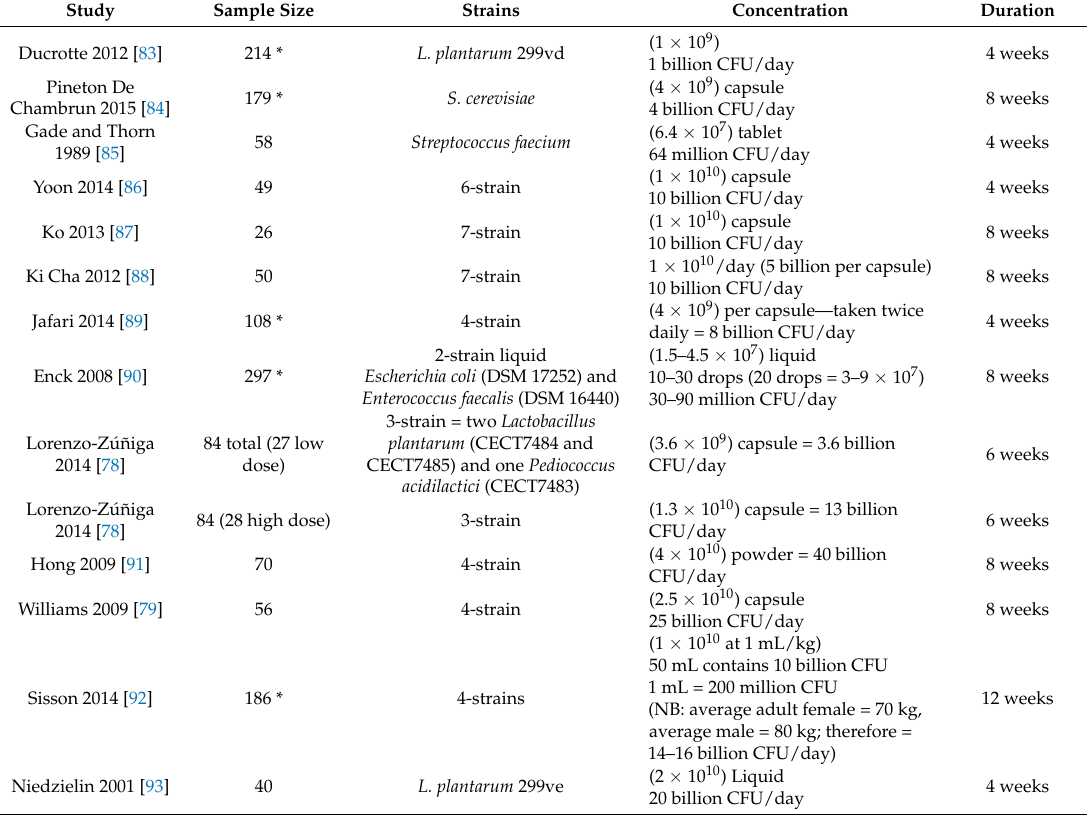
Table 1. This is a table presenting those studies analysed in the 2016 British Dietetic Association (BDA) review that had a clinically meaningful